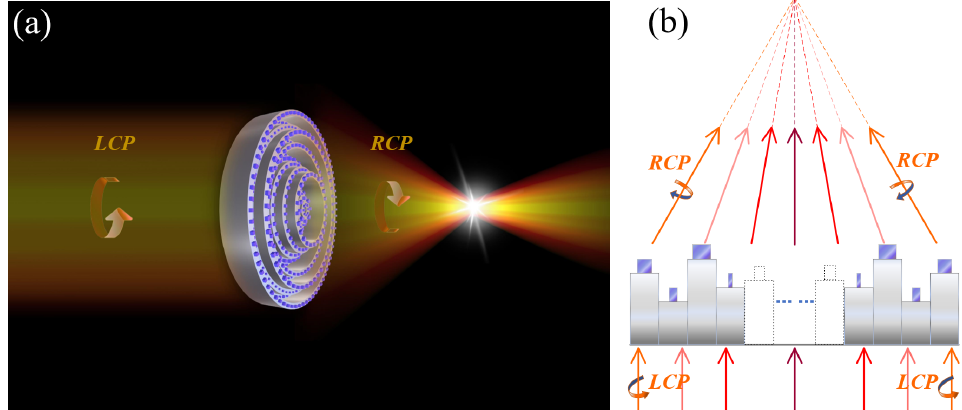
Figure 1. Schematic diagram of the MMZP designed for broadband focusing and polarization manipulation. The colors of the beams represent the different wavelengths. The arrow represents the spin state of the beam. ( a ) Three-dimensional diagram. ( b ) Sectional